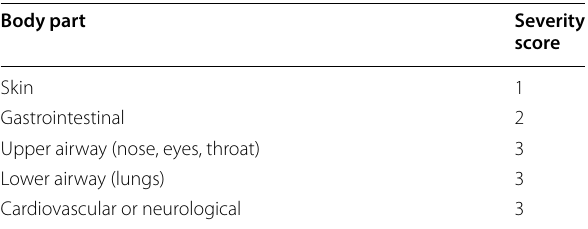
Table 1 Scoring system of reaction severity by van der Zee et al.